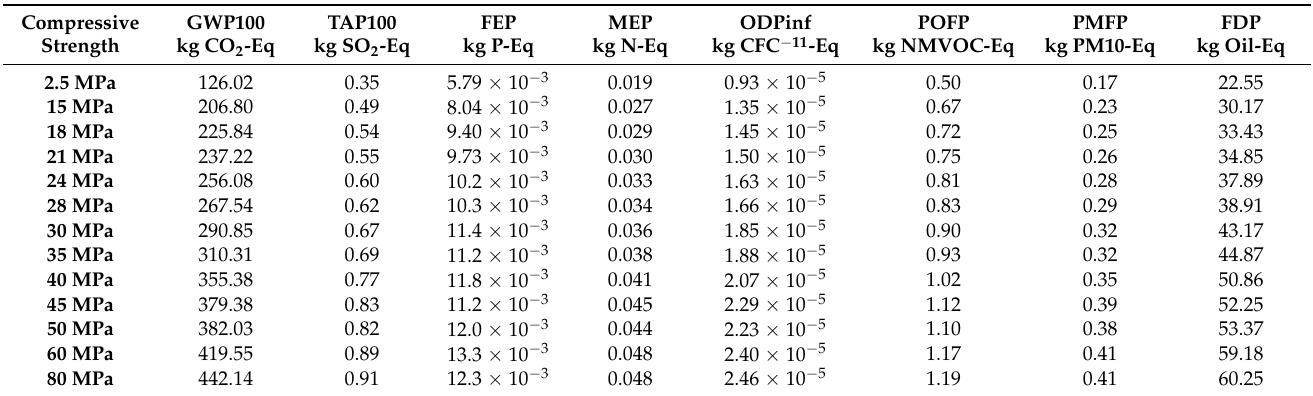
Table 3. Result of life cycle evaluation impact categories for 1 m 3 of ready-mixed concrete with different compressive strengths in